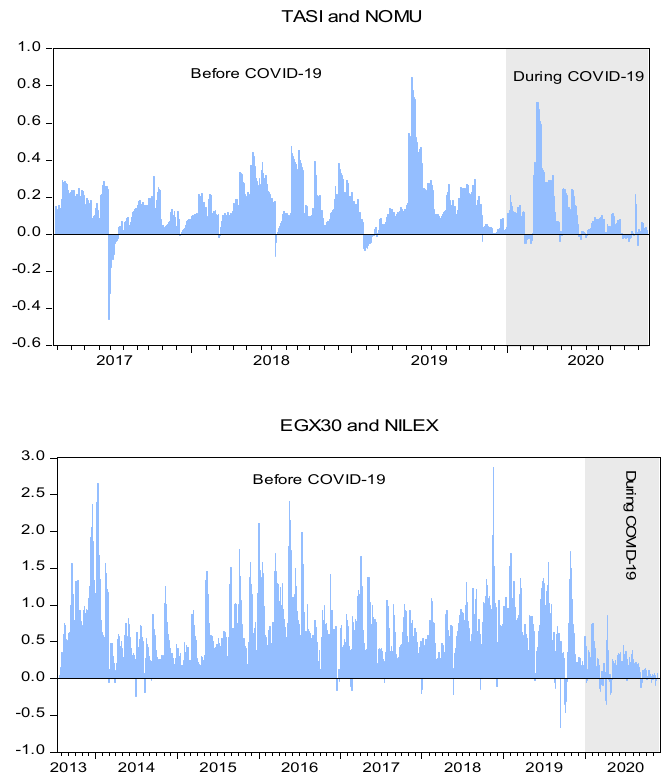
Figure 6. Time-varying hedge ratios computed from the VAR (1)-asymmetric DCC–GARCH (1,1)